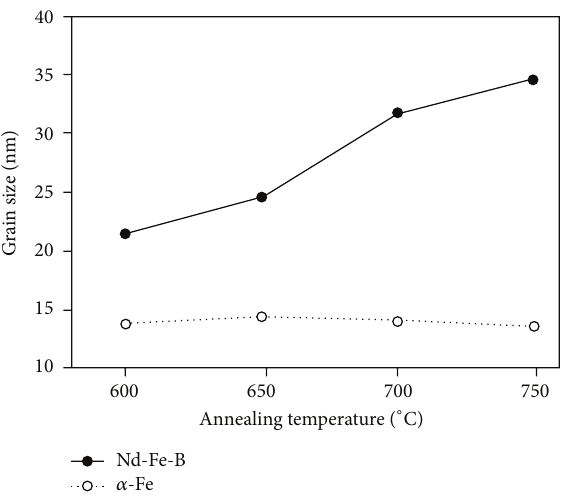
Figure 5: Grain sizes of Nd 9.4 Pr 0.6 Fe 74.5 Co 6 B 6 Ga 0.5 Ti 1.5 C 1.5 annealed ribbon at different annealing temperature for 10